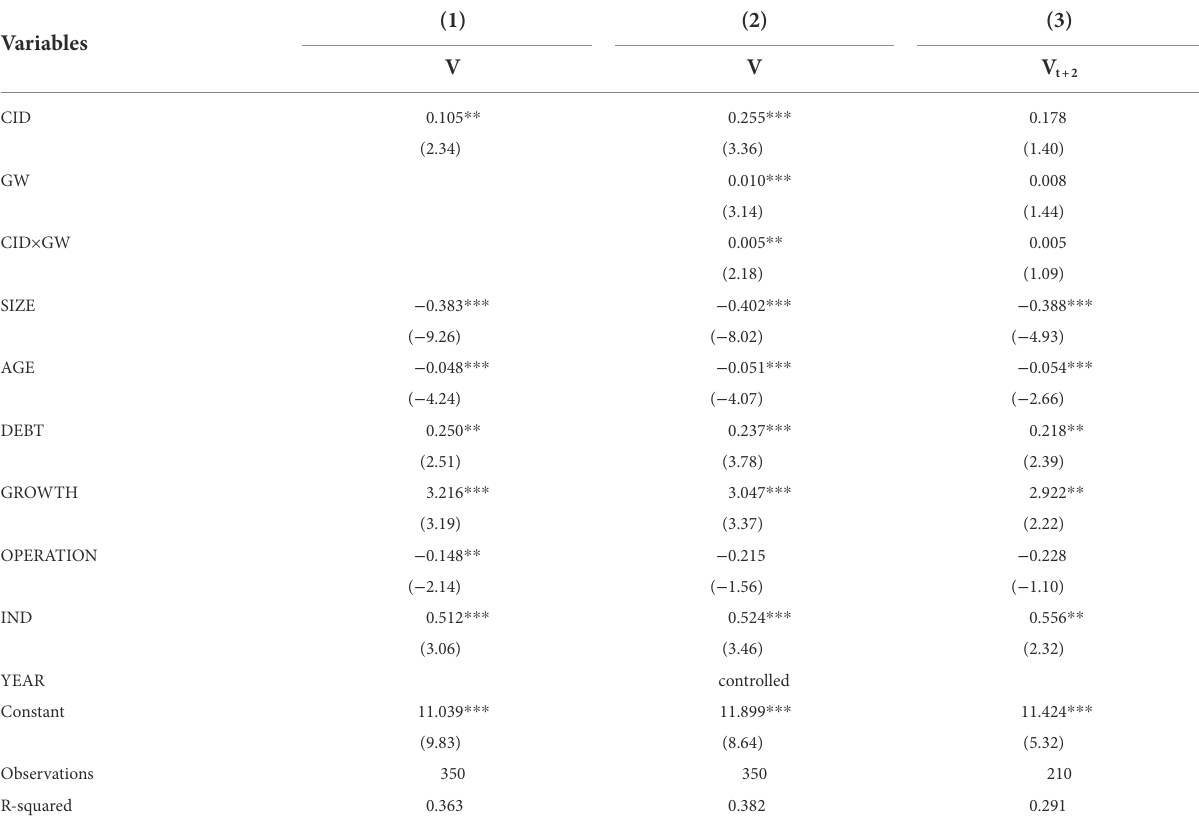
TABLE 12 Multiple regression